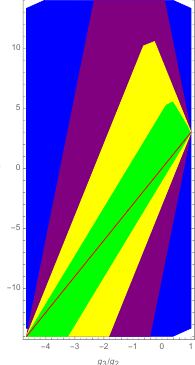
(cid:128) f (cid:138) = kg 3 , g 3 for f with 2 2 f 2 f 2